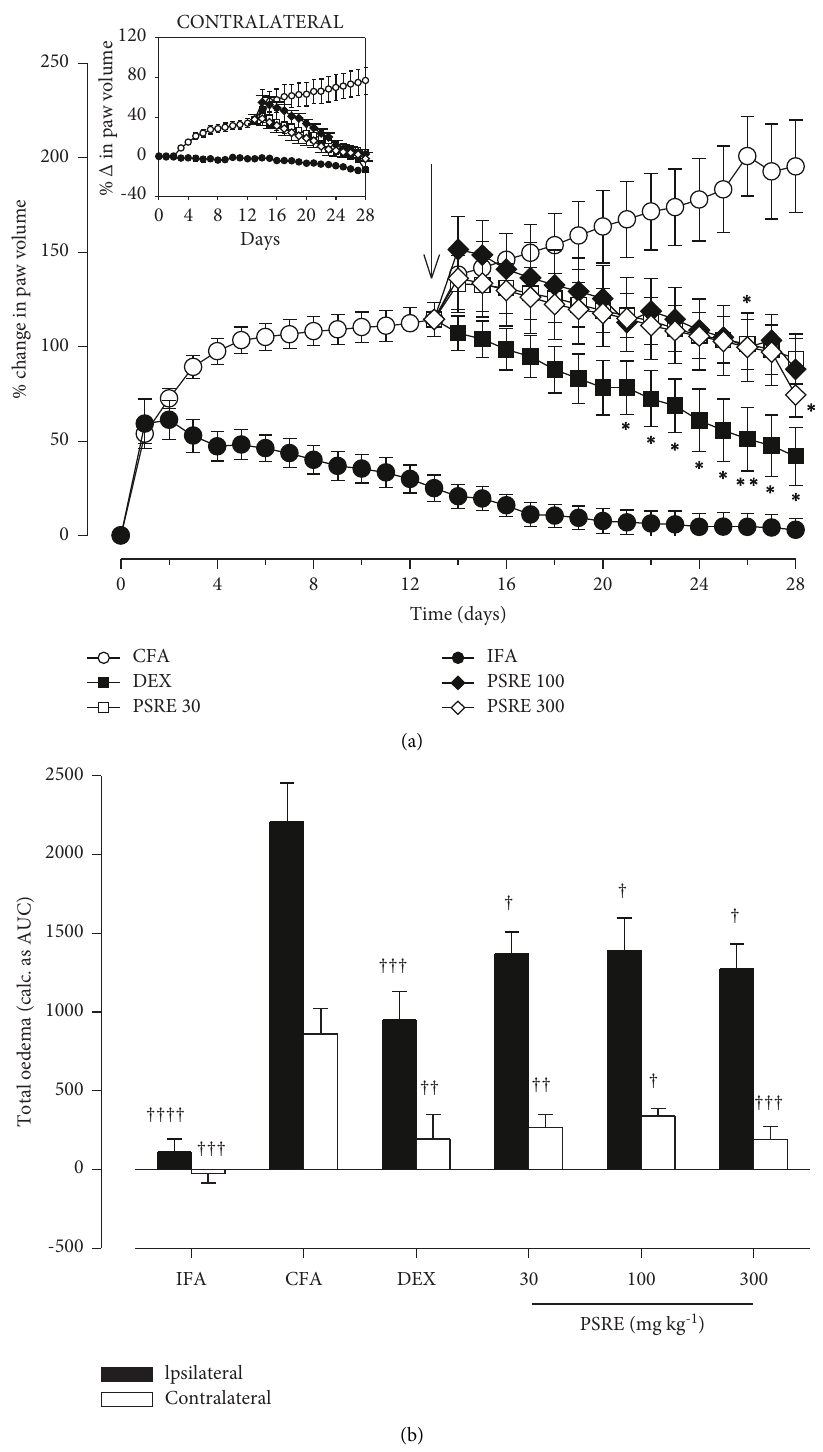
Figure 2: Effect of therapeutic administration of PSRE and dexamethasone on time-course curves (a) and total paw edema (b) in adjuvant- induced arthritis in rats. Data is presented as Mean